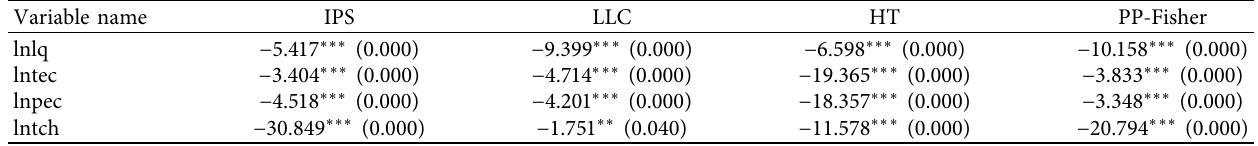
Table 2: Panel unit root test.